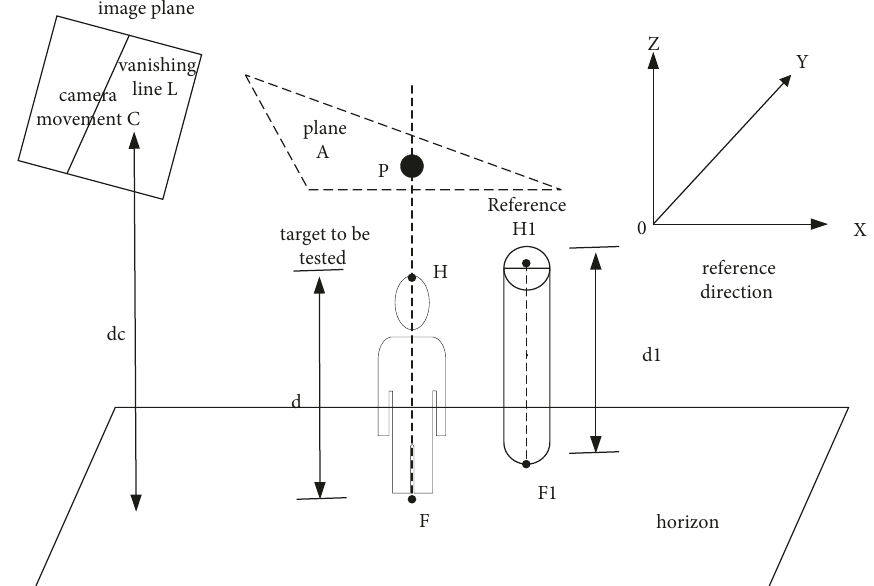
Figure 4: Simulation diagram of actual space.